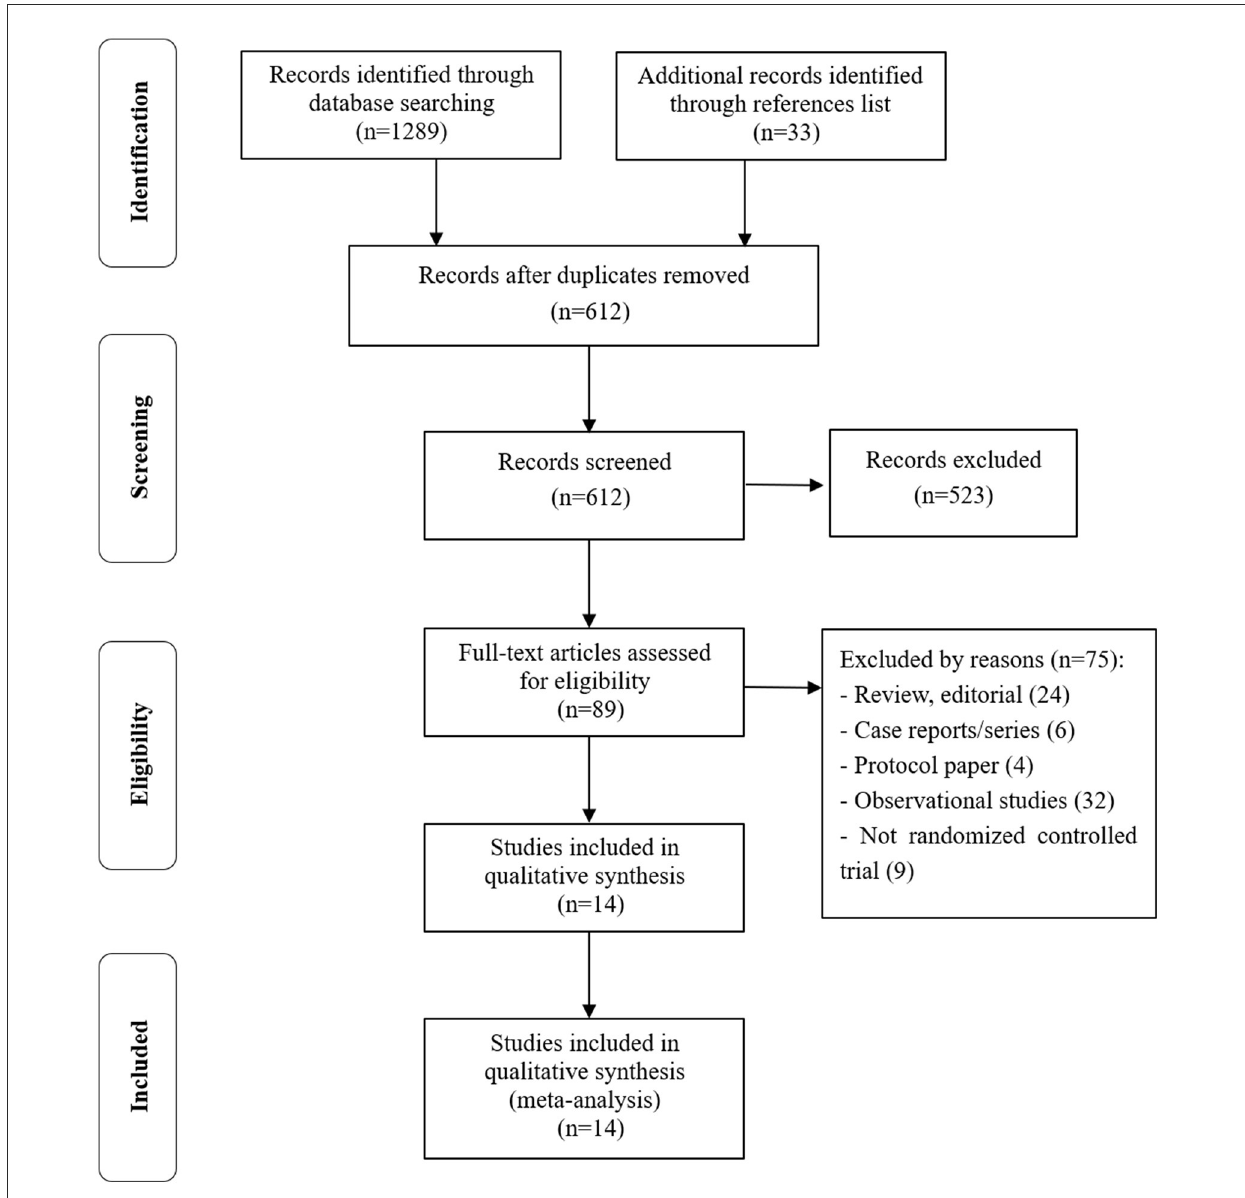
FIGURE1 Flow diagram for the study selection